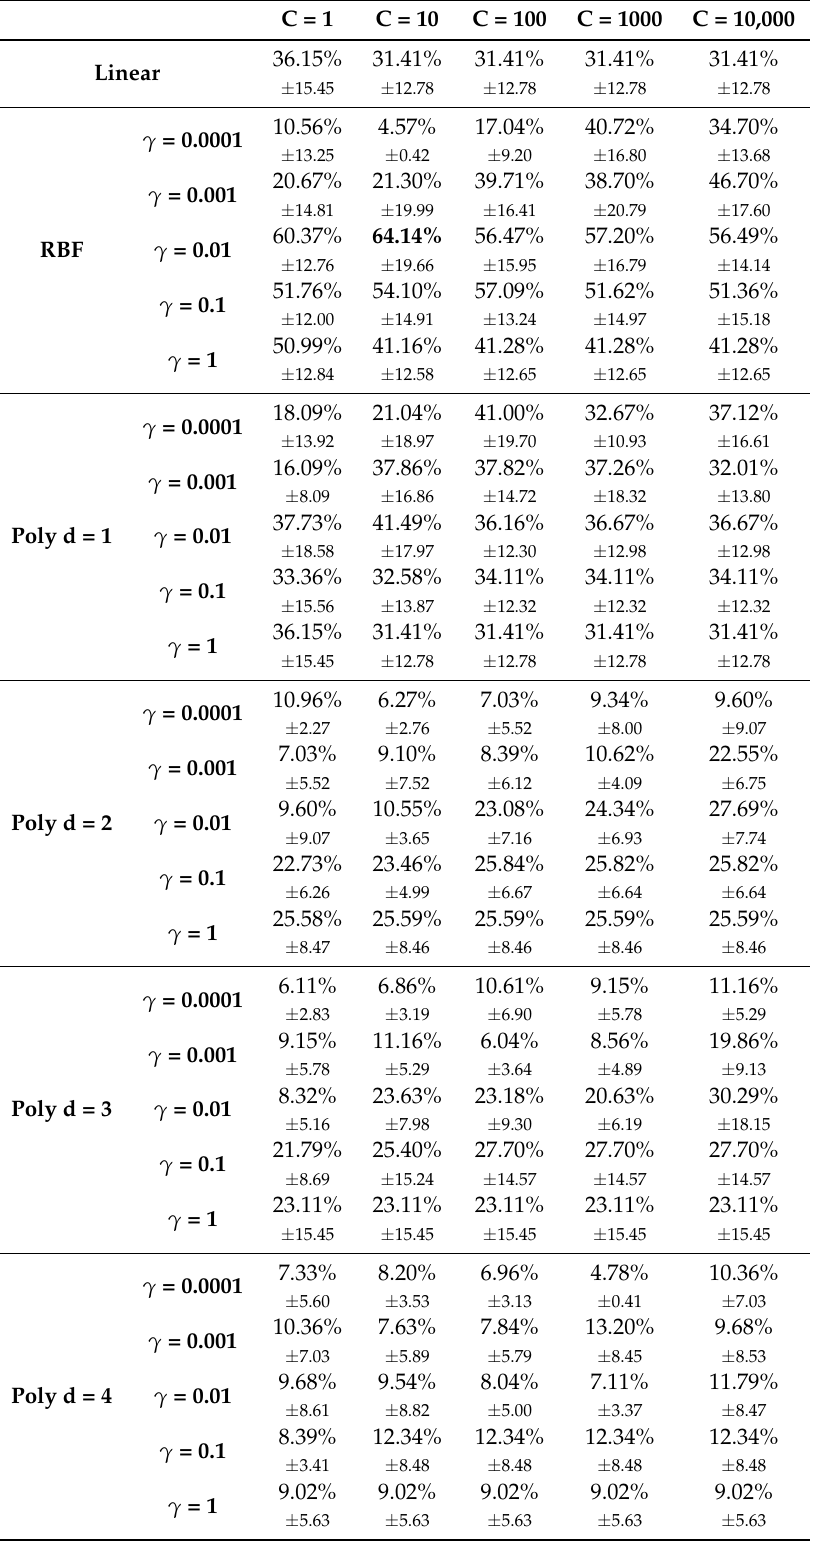
Table 8. Mean f1-scores achieved for each combination of kernel, C, γ and degree hyperparameters in the grid search. The best result found is highlighted in